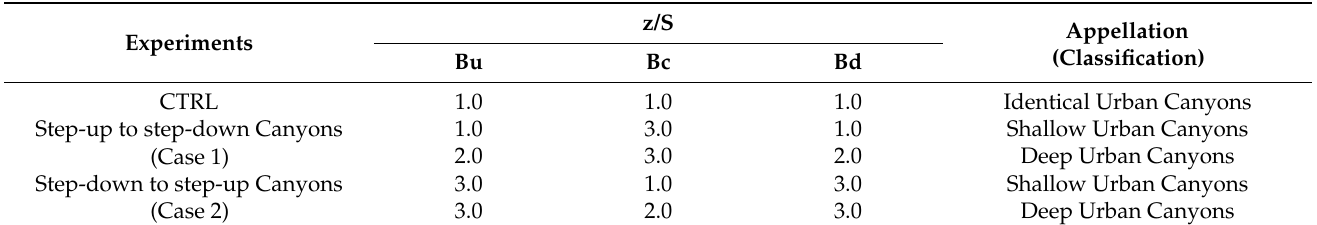
Table 1. Summary of the experiment conditions of building aspect ratio in urban